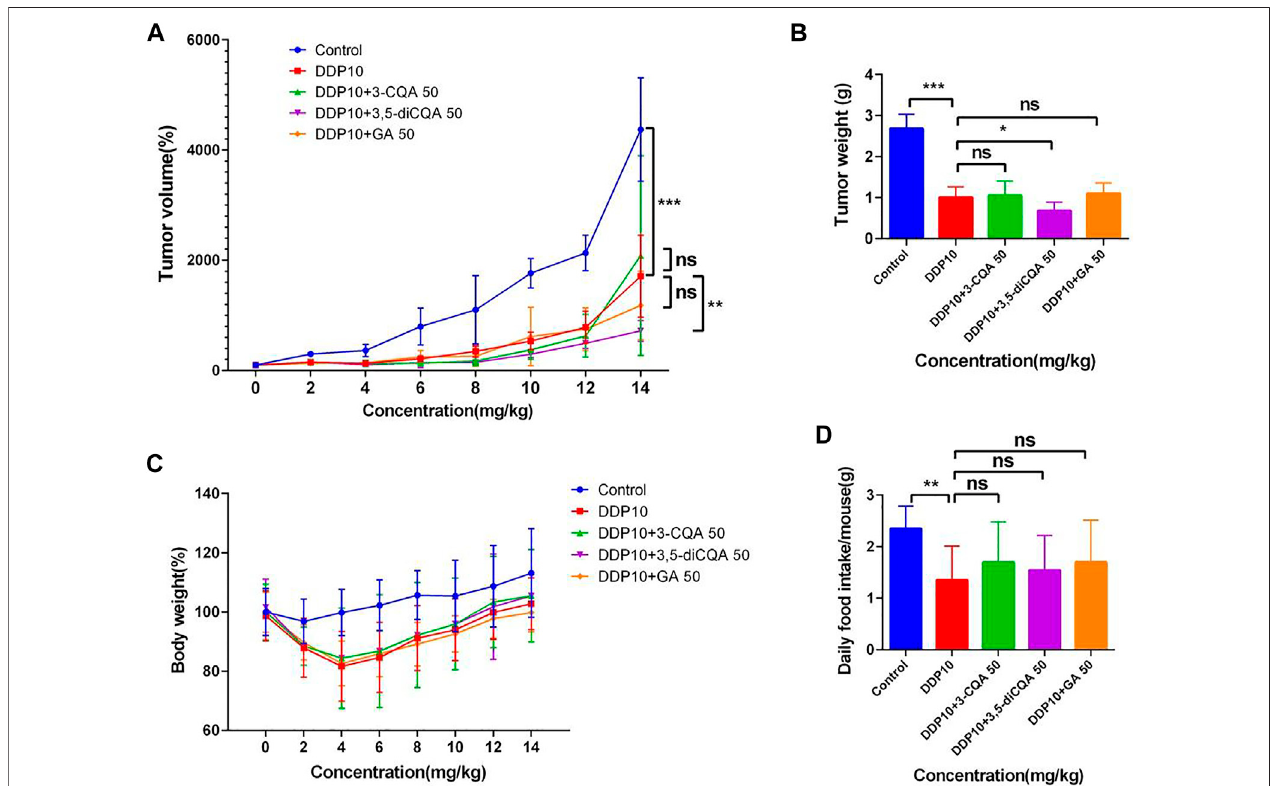
FIGURE 10 | Effects of different compound on the antitumor activity of DDP in vivo . (A) Tumor growth trends in different groups of mice. (B) Different groups of mousetumor weightintheend oftheexperiment. (C,D) Changesinbodyweightandfoodintakeofmiceindifferentgroups.Errorbarsarerepresented asmean±SEM. The p values were determined by Student ’ s t test (* p < .05, ** p < .01, *** p < .001). Details of experimental procedures are given in Materials and Methods